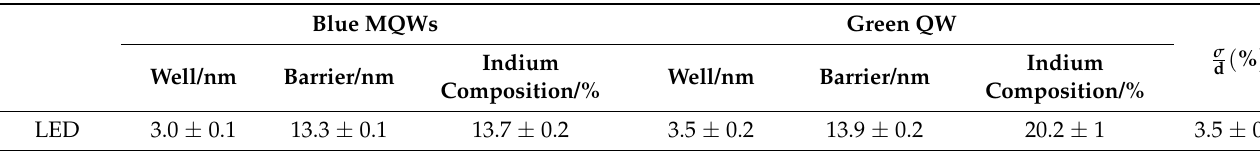
Table 1. The structural parameters of the dual-wavelength LED.